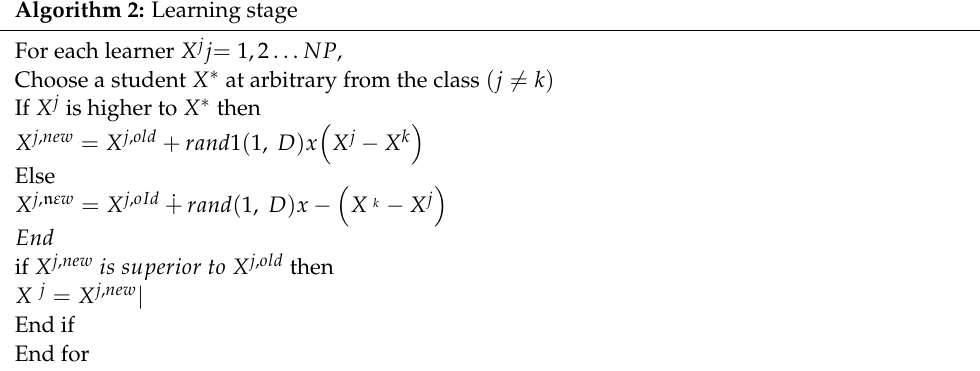
Algorithm 2: Learning stage